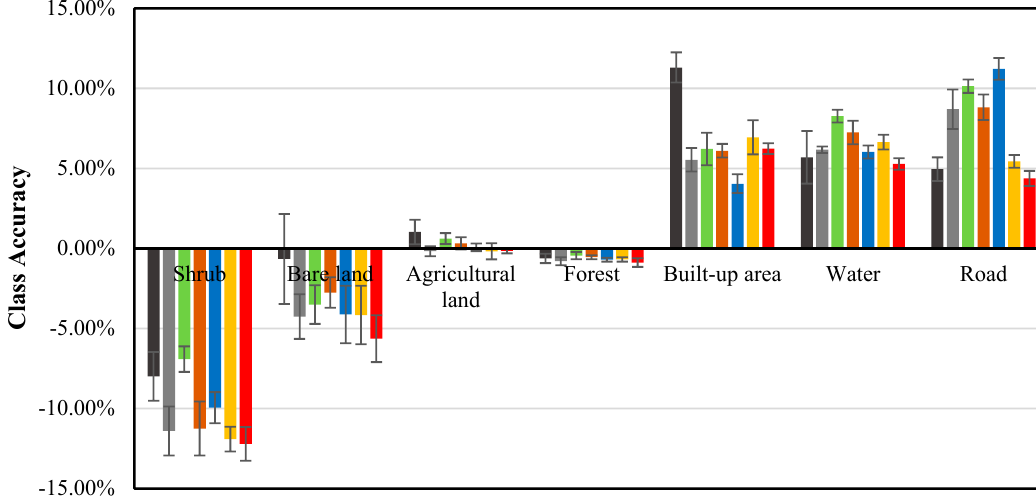
Figure 7. Differences between extended attribute profiles (EAPs) and Grey-Level-Co-occurrence Matrix (GLCM) on class accuracy. Columns above x -axis stand for adding GLCM achieved a higher accuracy than EAPs on their corresponding classes, and those below x -axis are the opposite.